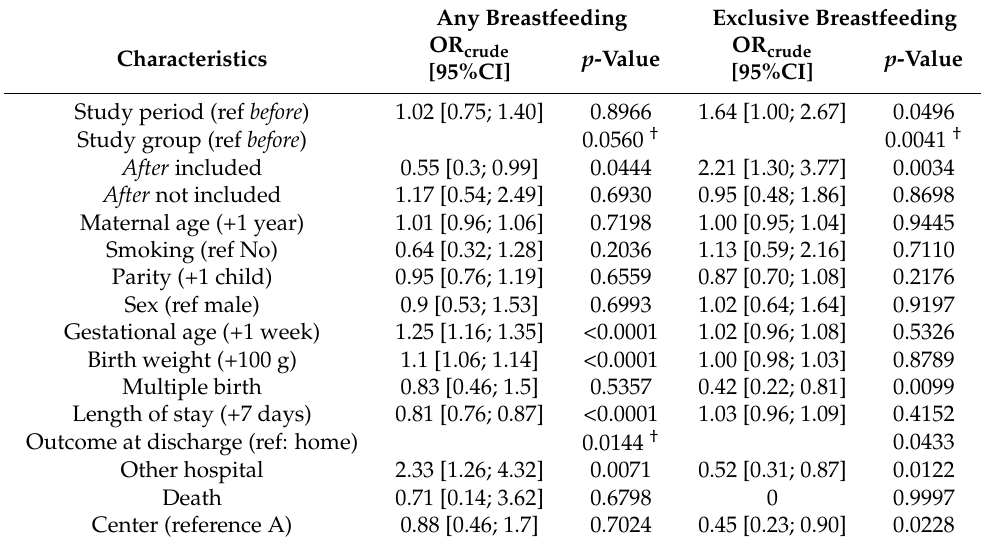
Table 4. Univariate analysis of any breastfeeding and exclusive breastfeeding among infants accord- ing to Doal inclusion